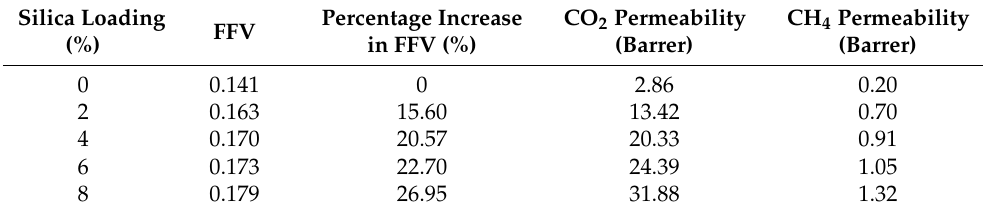
Figure 7. Comparison of permeability in PES/unmodified silica MMM and PES/modified silica MMMs. Table 3. Effect of modified silica loading on FFV of MMMs and gas